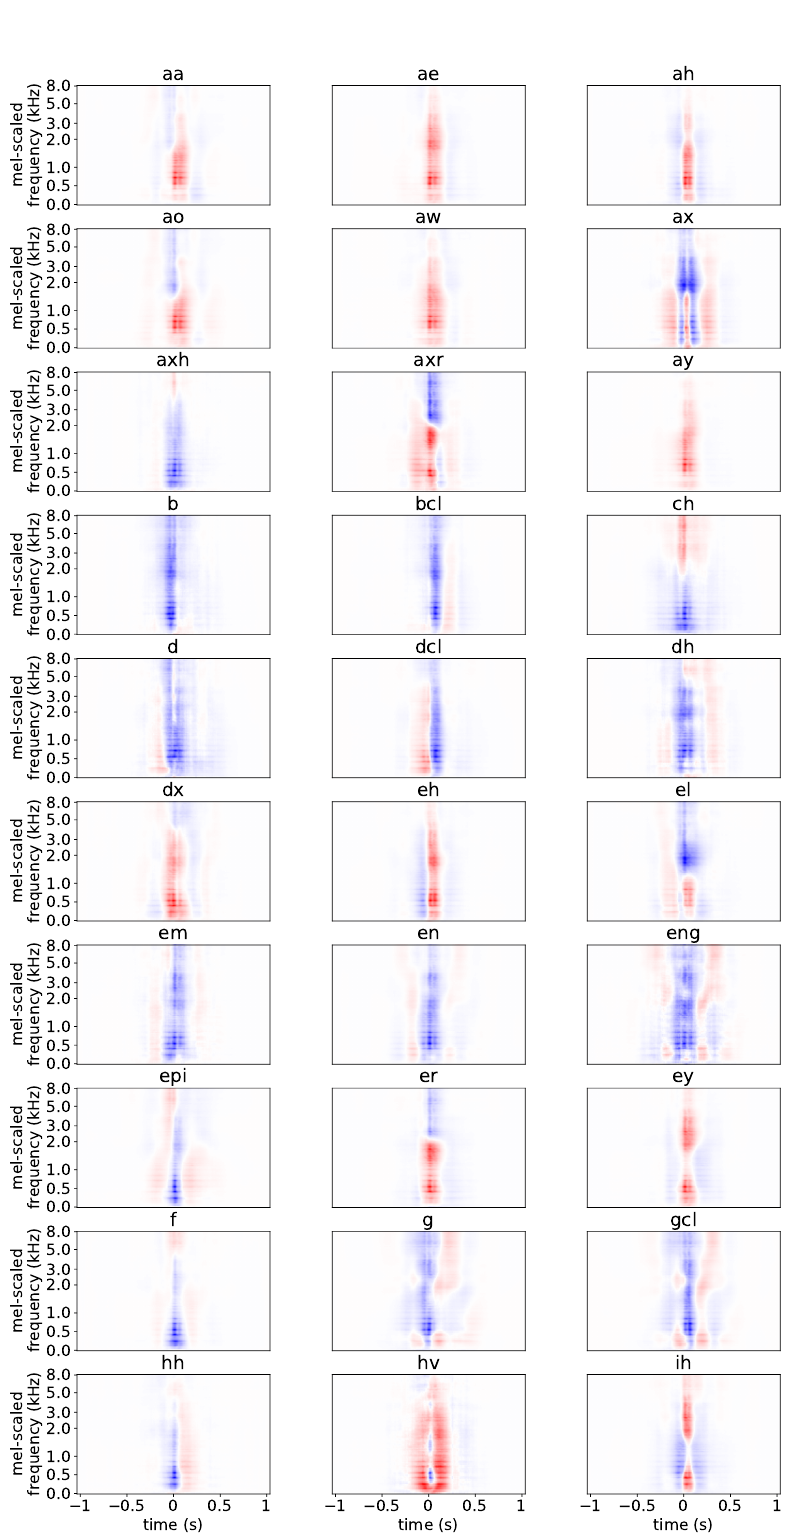
Figure A4. Input layer SNAPs in model W2L for phonemes aa – ih